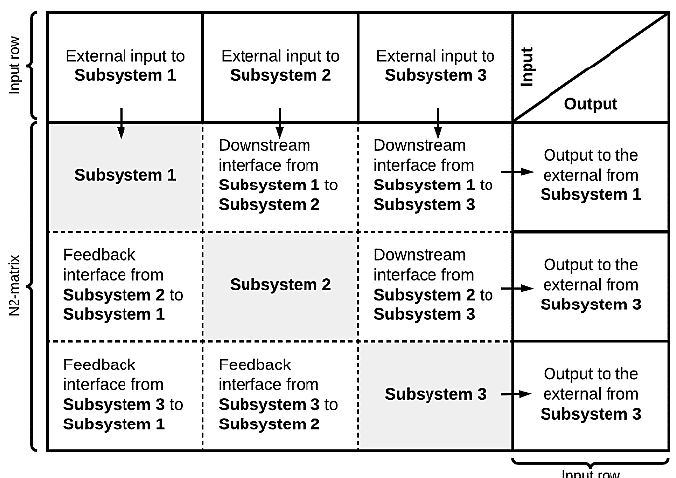
Figure 4. Generic interface diagram.